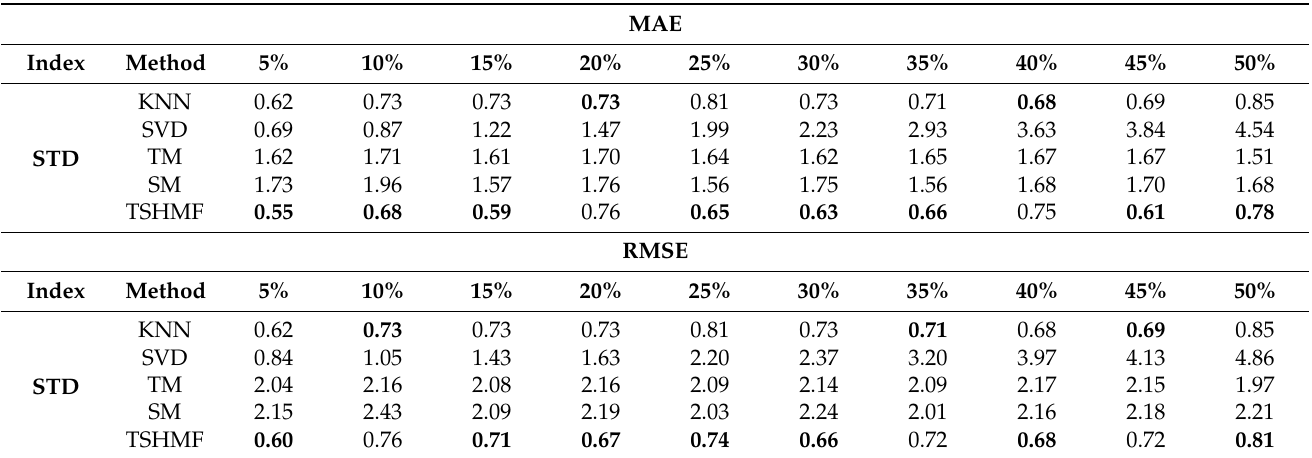
Table 2. Descriptive statistics in continuous missing scenarios of all